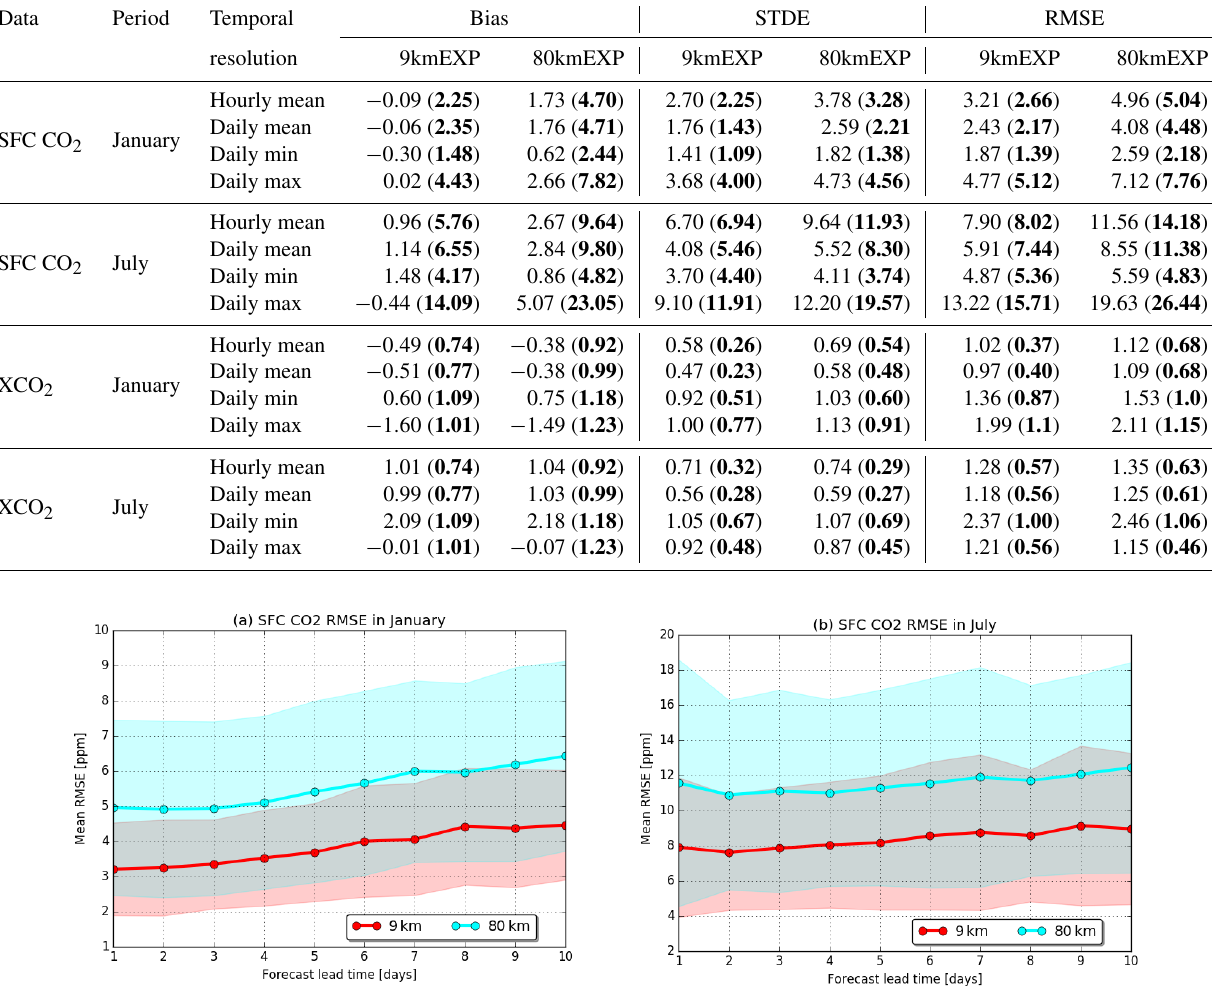
Figure 9. Mean RMSE of near-surface CO 2 (ppm) at different forecast lead times for the 9kmEXP (red) and 80kmEXP (blue) in (a) January and (b) July. The errors are computed with respect to hourly continuous in situ surface measurements from 51 stations (see Table A1). The error standard deviation between the different stations is shown with the shaded area: red for 9kmEXP, blue for 80kmEXP and grey for overlap. Note that different scales are used in each